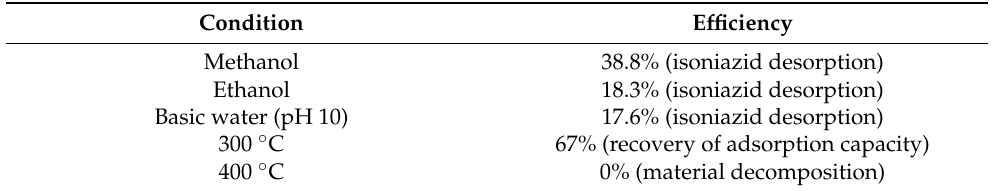
Table 7. BAC preliminary regeneration studies.